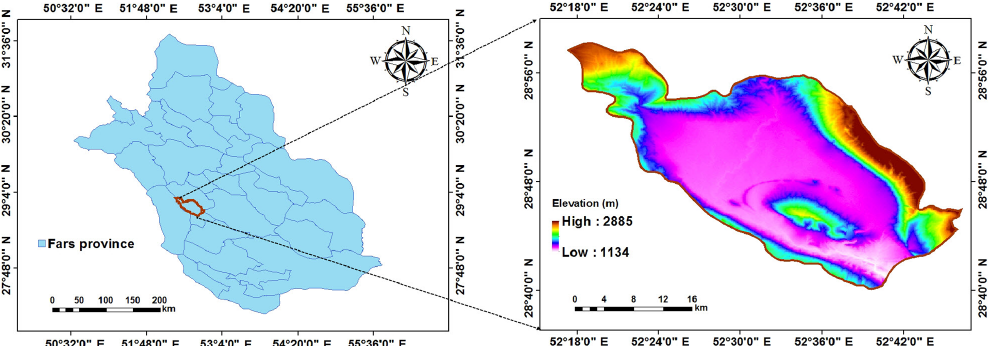
Figure 2. Location of the study area (DEM with a spatial resolution of 30m; source: http://earthexplorer.usgs.gov). Table 5. Pair-wise comparison matrix for drinking water quality based on content of inorganic components. Parameters Ca Cl Na EC Mg SO 4 TH TDS Weight Ca Cl 0.5 Na 0.33 EC 0.25 0.33